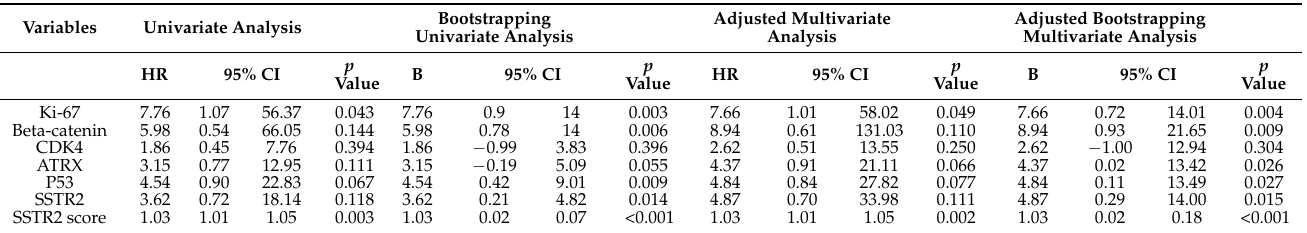
Figure 1. Kaplan-Meier curves for overall survival. ( A ) SSTR expression score ( B ) Ki-67. Table 4. The Cox proportional hazards model and bootstrapping of the association between immuno- histochemical staining and